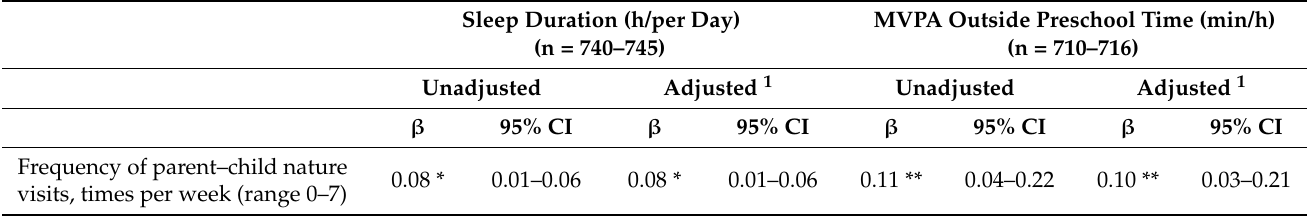
Table 2. Linear regression analyses of the associations between the frequency of parent–child nature visits per week and children’s sleep duration and MVPA outside preschool time.